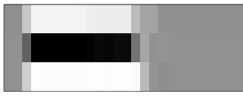
Figure 8. Sample of S5.